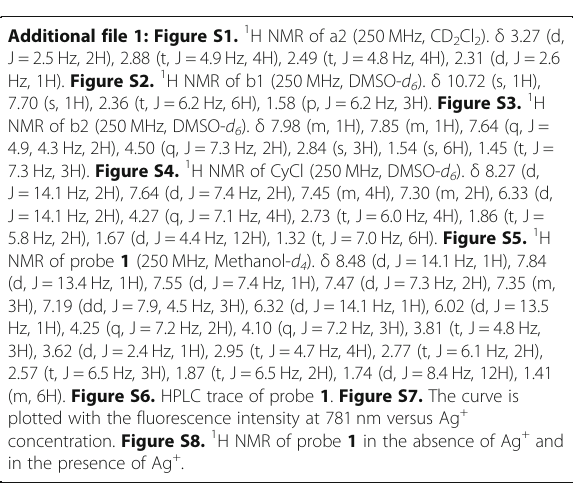
Table 1 Determination of Ag + from real wastewater samples